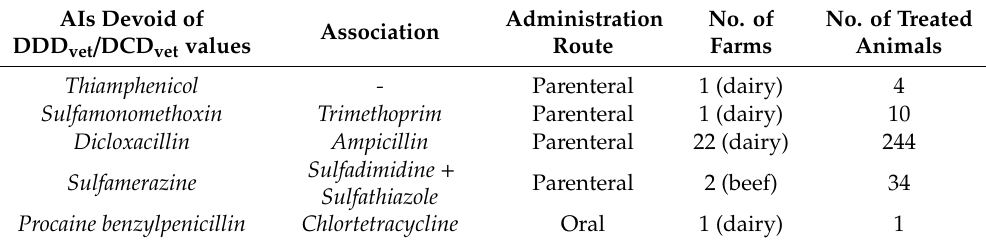
Table A5. Active ingredients devoid of DDD vet / DCD vet values and relative usage. AIs Devoid of DDD vet / DCD vet values